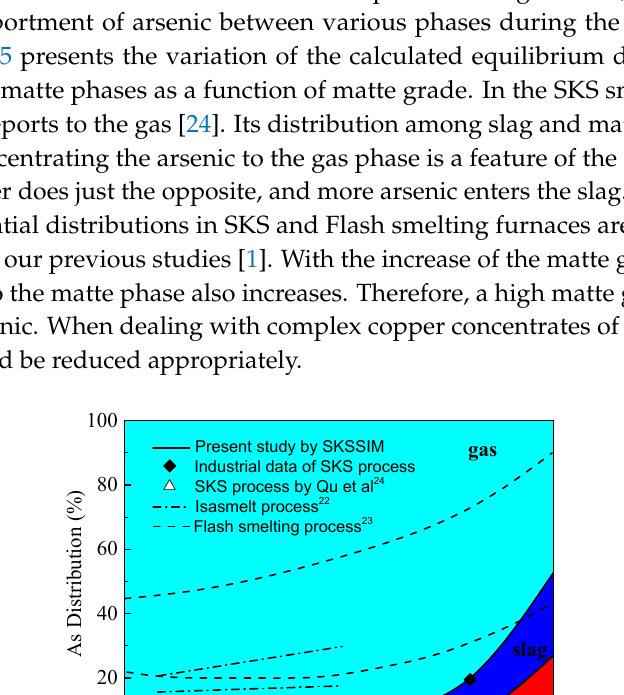
Figure 5. Arsenic (As) distribution in the SKS smelting process.